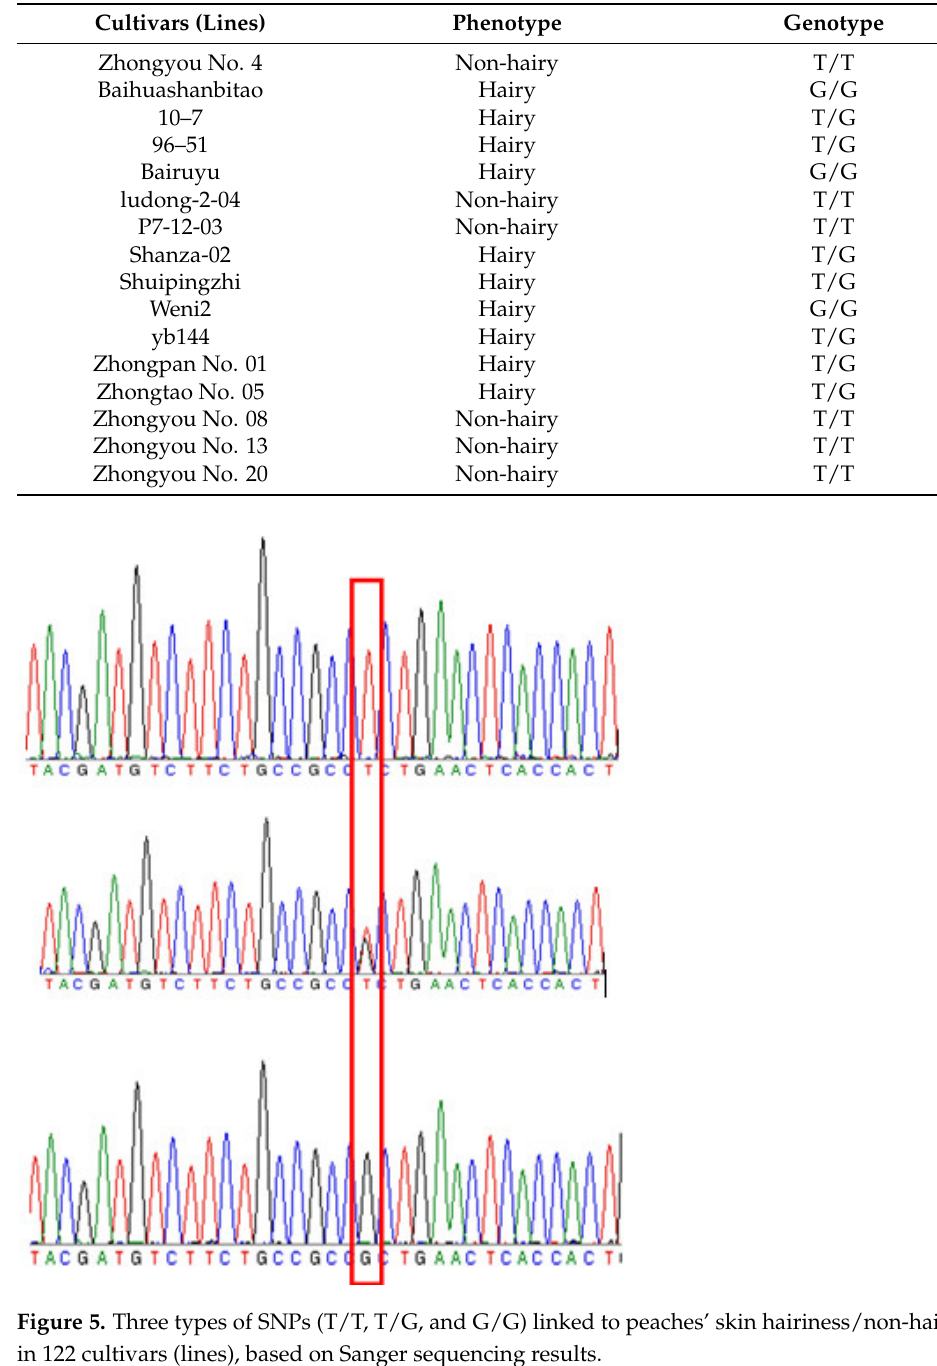
Table 2. Genotyping results for 16 cultivars (lines) regarding skin hairiness.